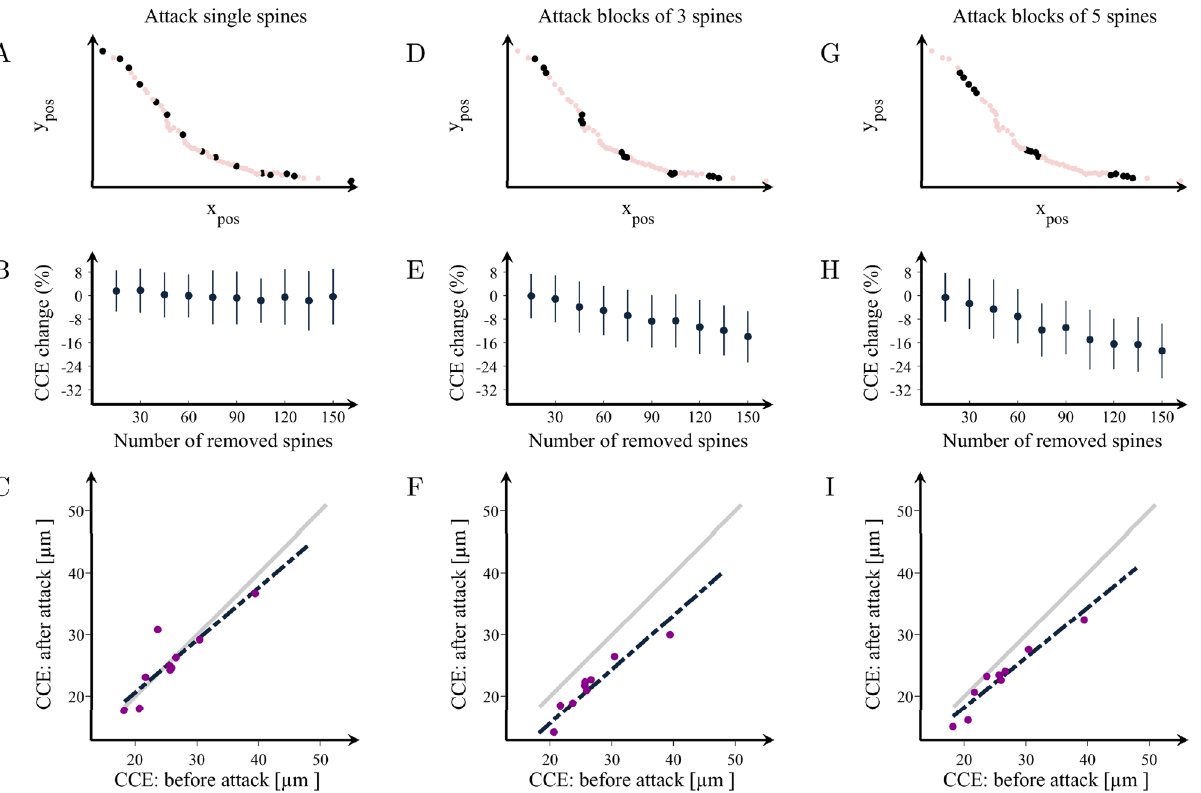
Figure 5. Changes in the organization of dendritic spines after attacks. Examples of attacks on spines in a representative dendrite at ( A ) random locations or in clusters of ( D ) 3 and ( G ) 5 spines. ( B,E,H ) Percentage change in the characteristic community extension (CCE) as a function of the number of removed spines in the three cases, respectively. CCE in the attacked vs. the non-attacked dendrites after the removal of 150 spines in groups of ( C ) 1, ( F ) 3 and ( I ) 5. The grey line shows the theoretical line of no change in the CCE, while the black line is the line that best fits the observed attack data. The values obtained after each attack can also be found in Supplementary Table S4. Means and standard deviations are computed over 100 random